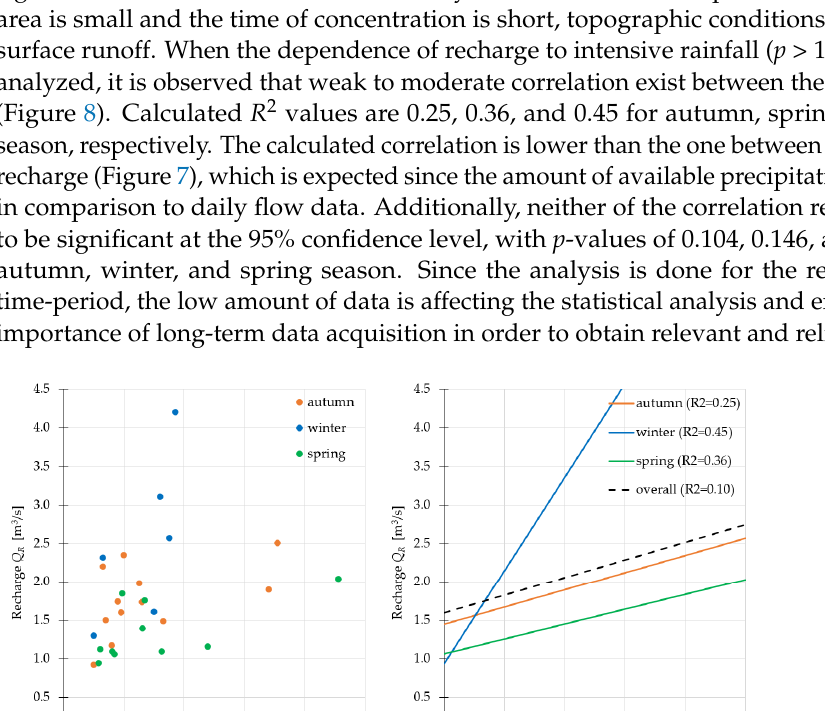
Table 3. Statistical parameters of the seasonal recharge/discharge and rainfall data.